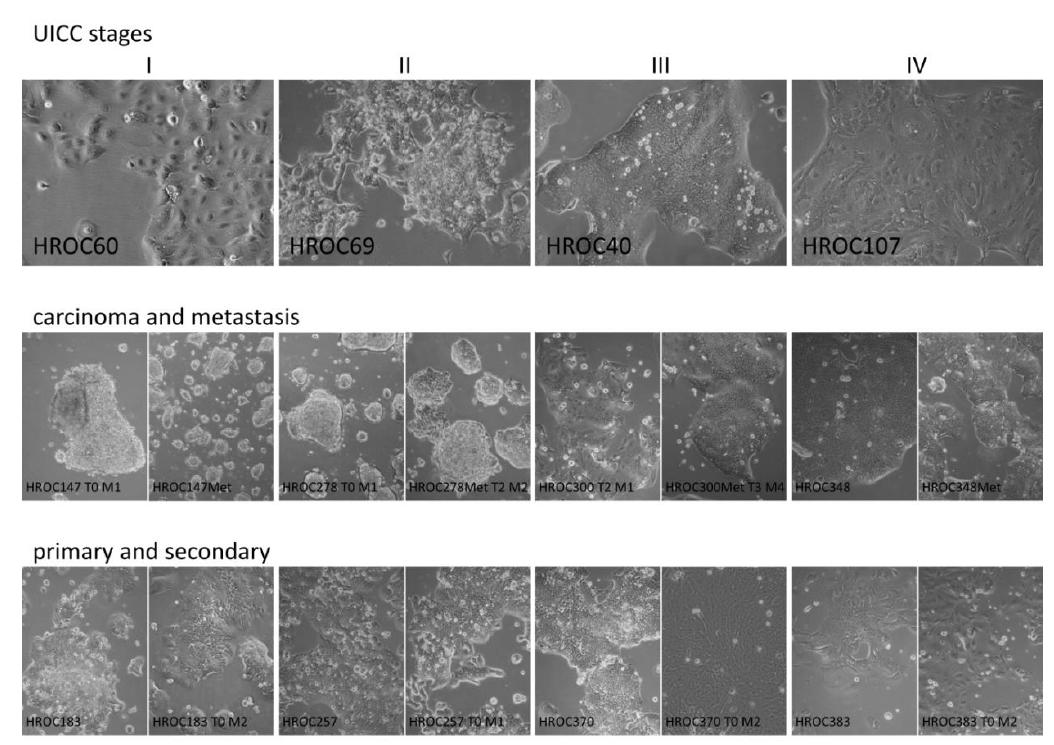
Figure 1. The figure depicts exemplarily the morphology of cell lines derived from tumors with UICC stages I, II, III, and IV (top, left to right), cell line pairs derived from carcinoma and corresponding metastasis (middle), and pairs of primary and corresponding secondary cell lines (bottom). The images were taken with a 10 × lens of a Primo Vert microscope (Carl Zeiss Microscopy GmbH, Jena, Germany).